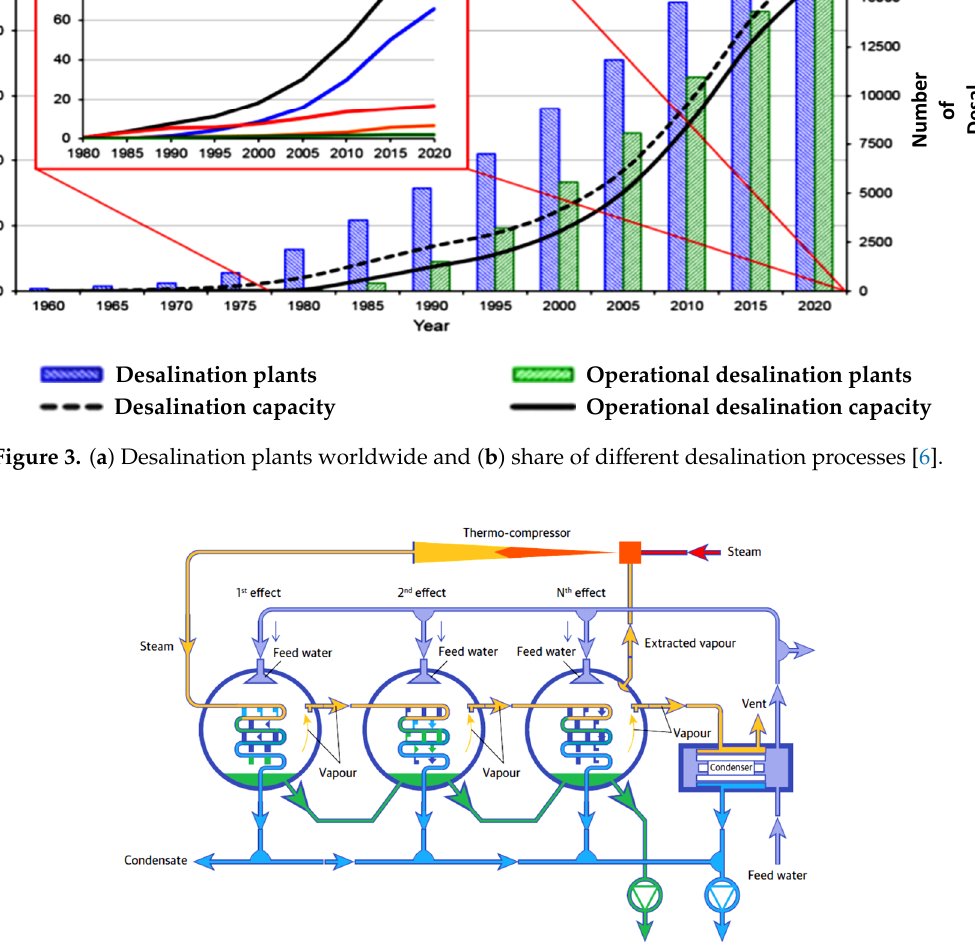
Table 3. Post-treatment processes required for various applications [18] [Copyright © 1998–2019 Lenntech B.V. All rights reserved]. Process